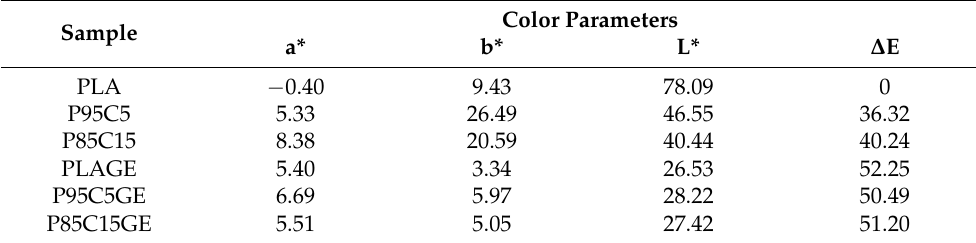
Table 4. Color measurements values of neat PLA and the blends.